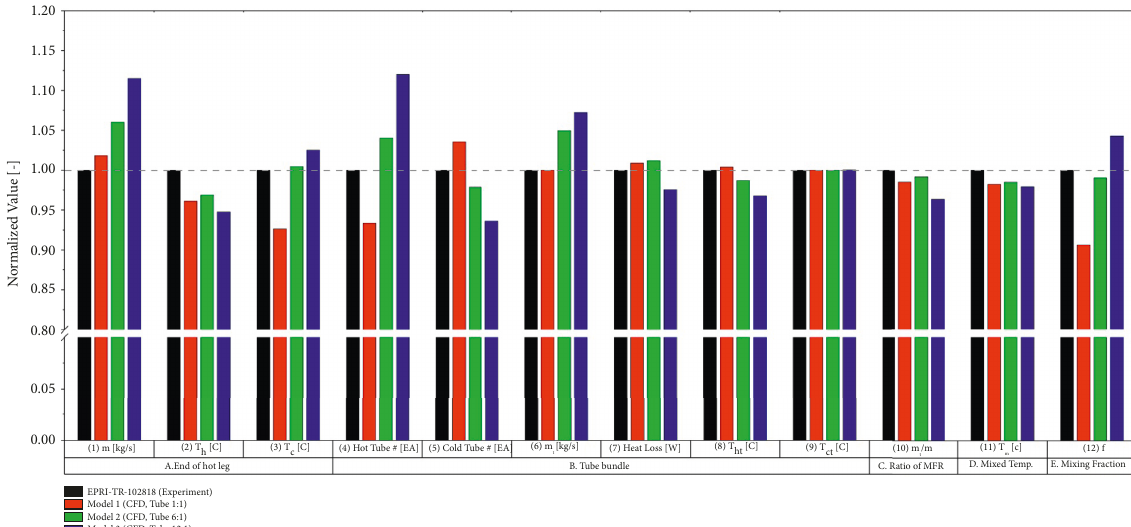
Figure 16: Comparison of the main evaluation factors for each model (normalized